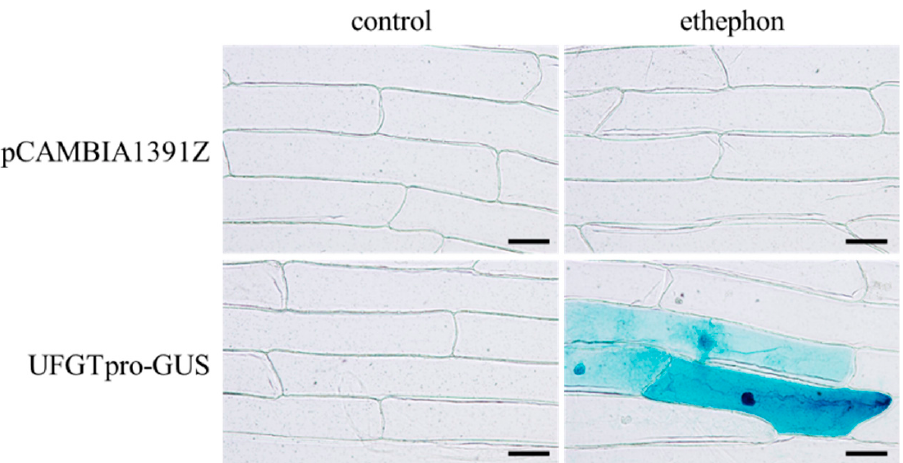
Figure 5. Activation of UFGT promoter by ethephon. After ethephon treatment, transformed onion epidermal cells with UFGTpro-GUS expression plasmid or pCAMBIA1391Z were subjected to GUS